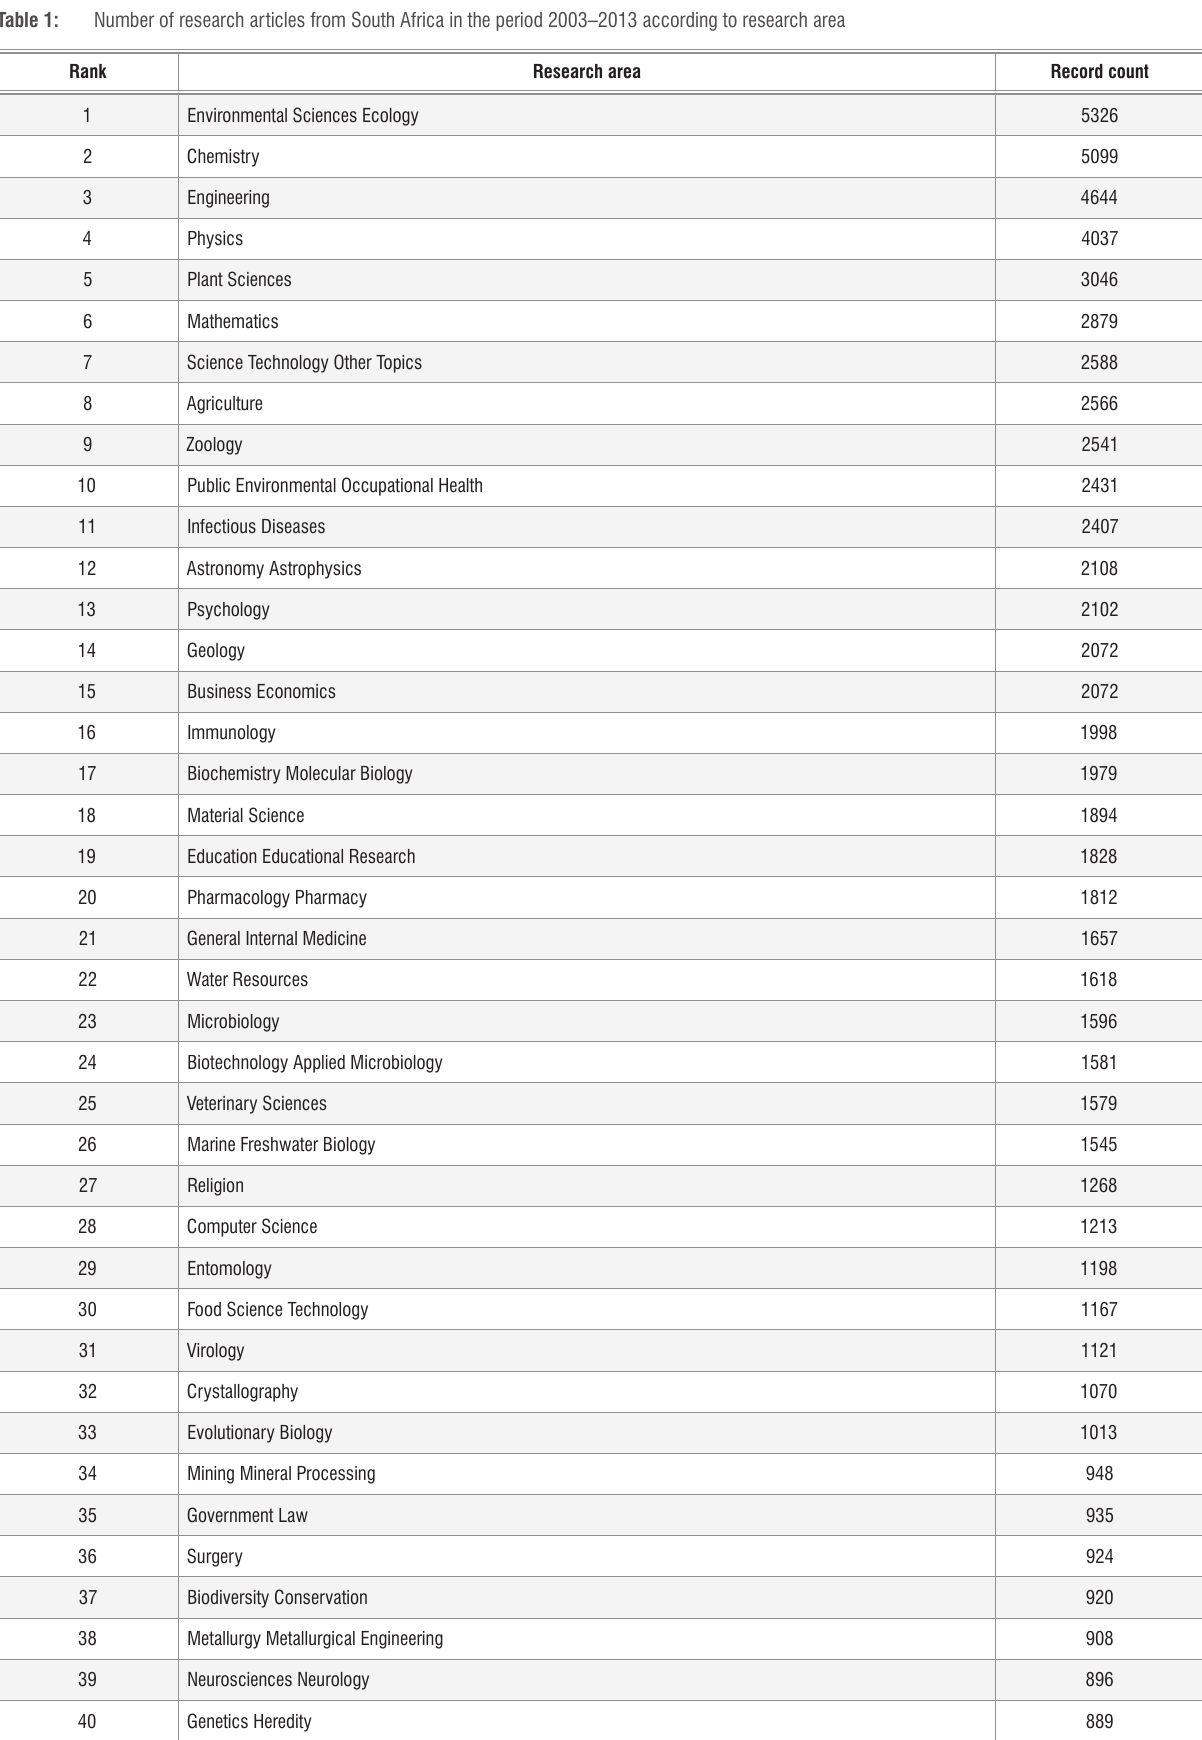
Table 1: Number of research articles from South Africa in the period 2003–2013 according to research